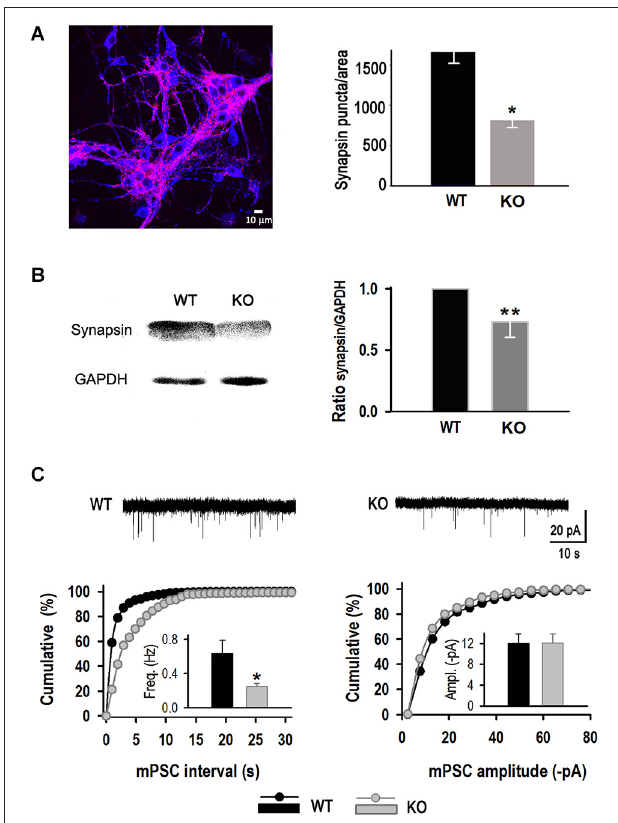
FIGURE 6 | Reduced synapse number in KLHL1 KO neurons. (A) Quantification of synaptic puncta. Right , merged image of hippocampal neurons stained for synapsin I (red) and MAP2 (blue) (11 DIV). Left , Number of synaptic puncta per area ( n = 11, 12). (B) Synapsin I quantification by Western Blot. Left , example blot. Right , data summary ( n = 5, 5). (C) Miniature postsynaptic current (mPSC) analysis. Top , miniature PSCs example traces. Bottom left , mPSC frequency distribution. Inset , mean frequency values (Hz). Bottom right , mPSC amplitude distribution. Inset , mean amplitude value for each population (pA) ( n = 10, 9). * p < 0.05, Student’s t -test; ** p < 0.05, paired Student’s t